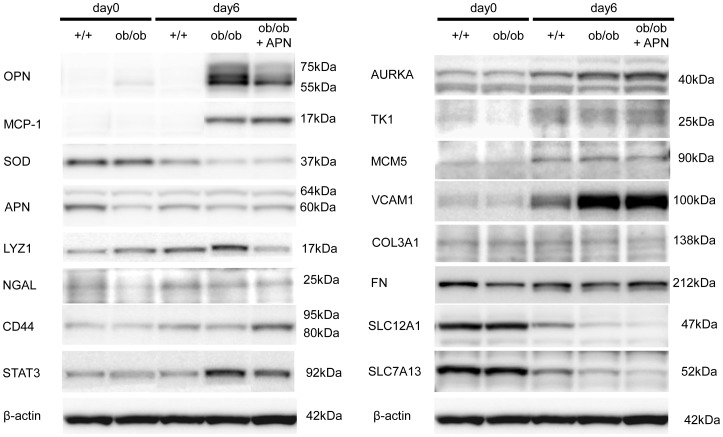
Confirmation of selected genes detected by microarray analysis.Western blot analysis for OPN, MCP-1, SOD, APN, LYZ1, AURKA, TK1, MCM5, NGAL, CD44, STAT3, SLC12A1, SLC7A13, VCAM1, COL3A1 and FN protein expression. Each molecular weight demonstrated as the bands were as follows. OPN, 75 and 55 kDa; MCP-1,17 kDa; SOD, 37 kDa; APN, 64 kDa; LYZ1, 17 kDa; AURKA, 40 kDa; TK1, 25 kDa; MCM5, 90 kDa; NGAL, 25 kDa; CD44, 80–95 kDa; STAT3, 92 kDa; SLC12A1, 47 kDa; SLC7A13, 52 kDa; VCAM1, 100 kDa; COL3A1, 138 kDa; FN, 212 kDa and β-actin, 37 kDa.